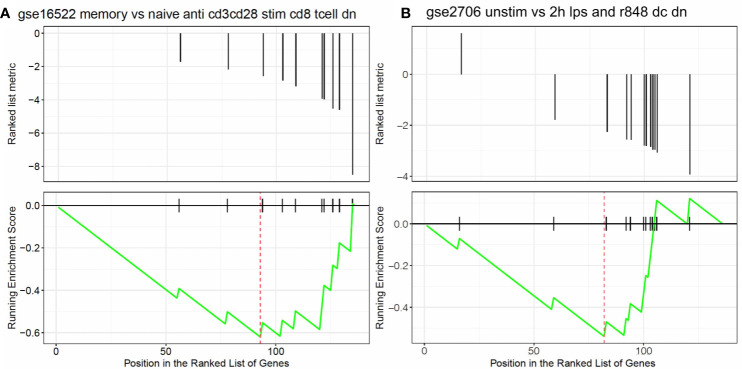
Results of the GSEA. Survival related IRGs were enriched in immunological pathways, especially in pathways associated with the differentiation of (A) naïve B cells vs neutrophils and (B) naïve CD8 T cells vs monocytes.